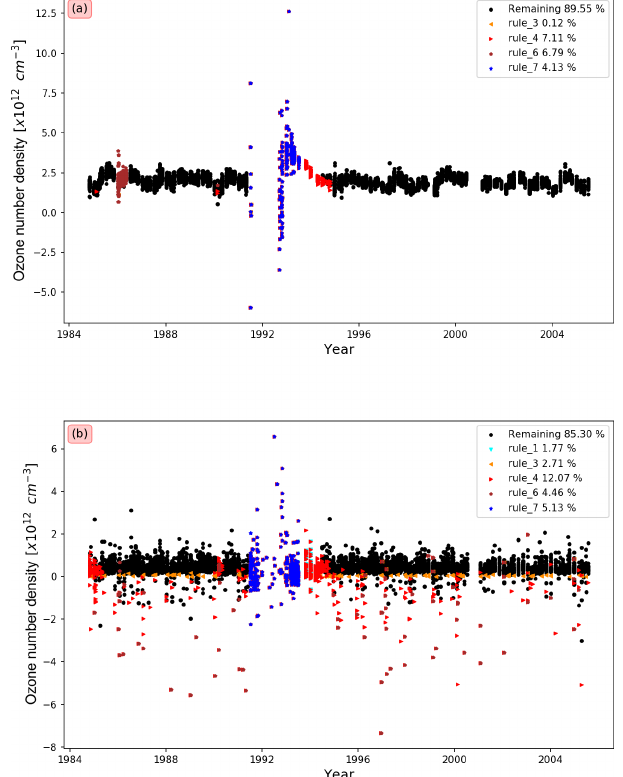
Figure 3. SAGE II ozone number density at 20km between 5 ◦ S and 5 ◦ N (a) and 16.5km between 25 and 15 ◦ S (b) before and af- ter data usage rules (Sect. 3) have been applied, as indicated in the legend. Each rule is associated with a percentage of data points that will be removed from the data sets if the rule is applied. For more details, see the main text.